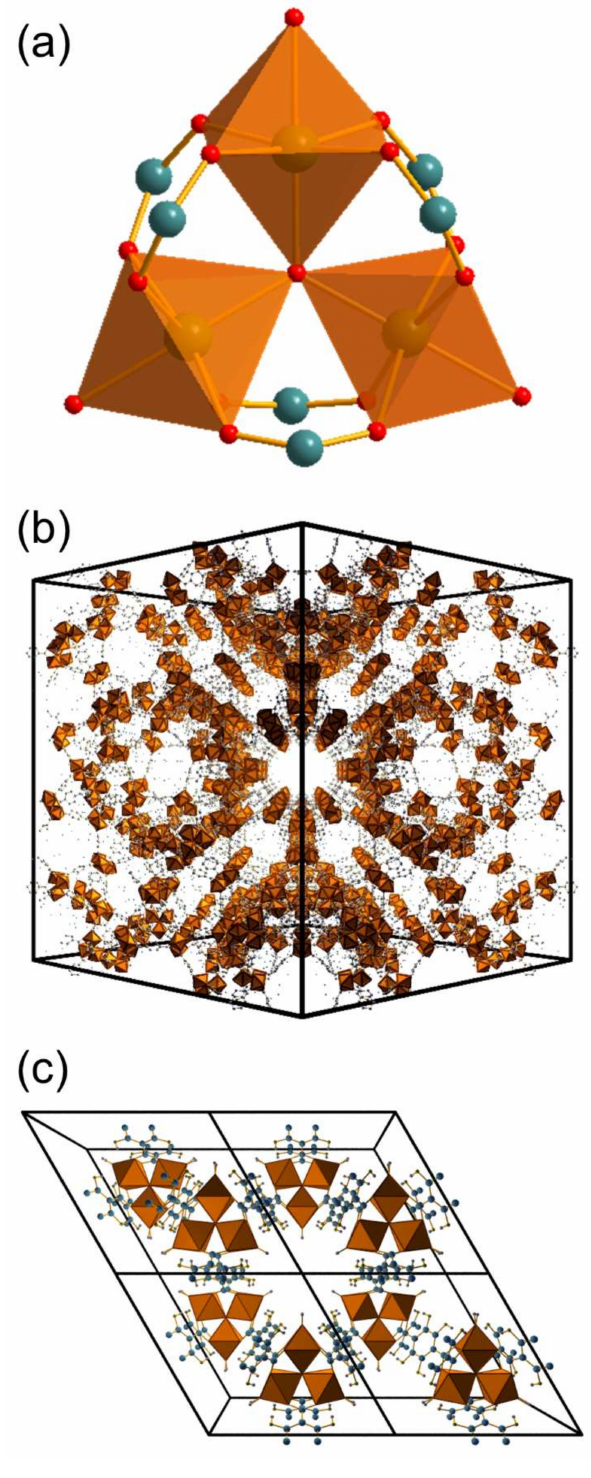
Figure 2. The structures of the MOFs investigated in this work: ( a ) the trimeric building unit showing three {FeO 6 } octahedral units linked by a common oxygen atom, ( b ) the cubic unit cell of MIL-101, and ( c ) four unit cells of hexagonal MIL-88B. Carbon atoms of the benzene-1,4-dicarboxylate (BDC) linker are shown as grey